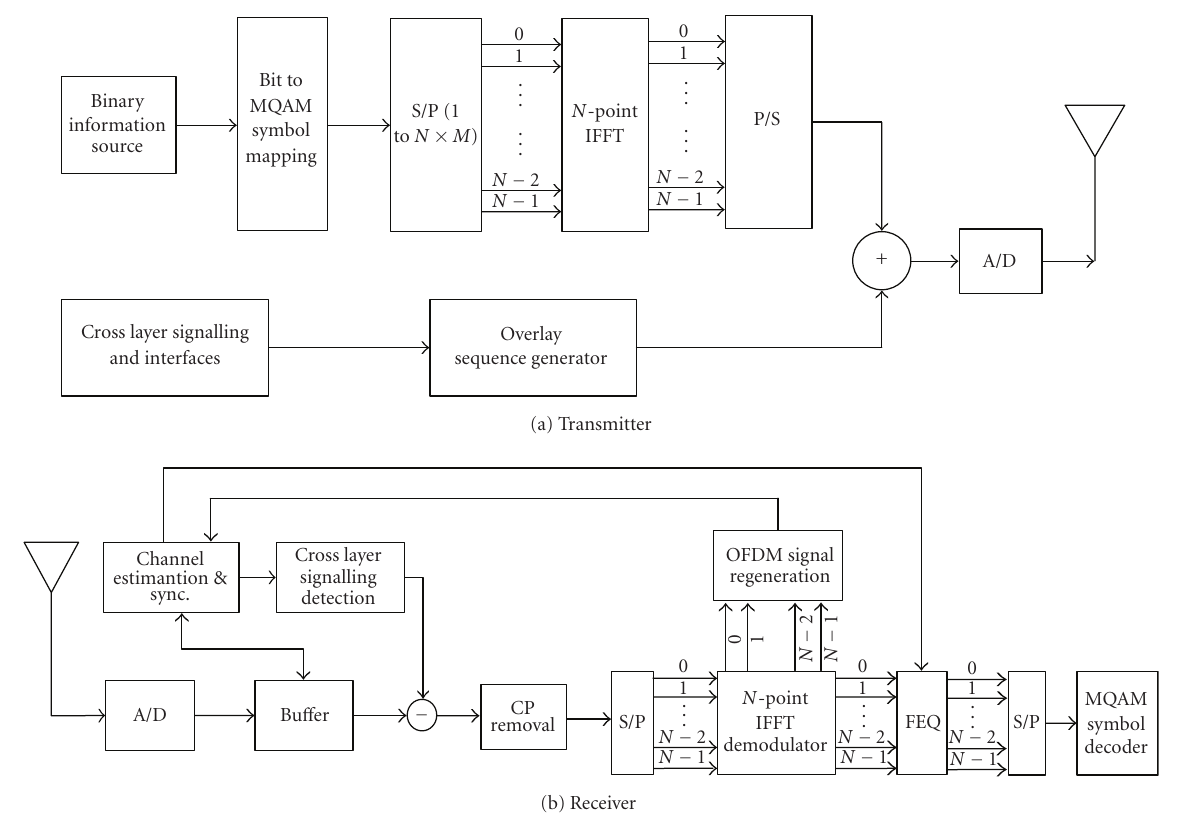
Figure 1: The transceiver block diagram for the OFDM system with overlay